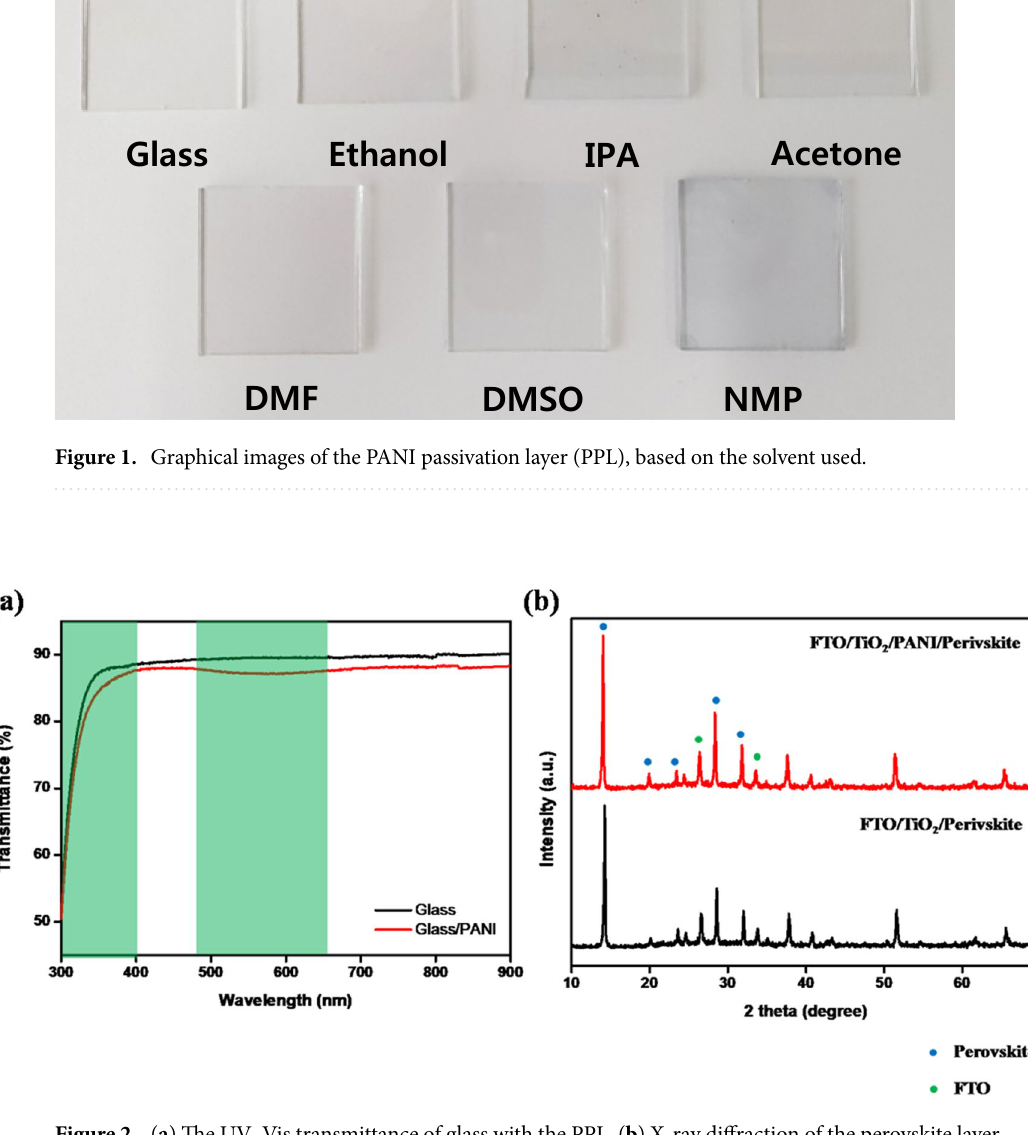
Figure 2. ( a ) The UV–Vis transmittance of glass with the PPL. ( b ) X-ray diffraction of the perovskite layer with/without